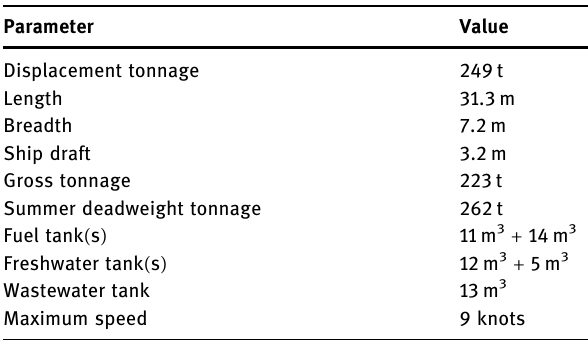
Table 1: Technical parameters of the research surveying vessel